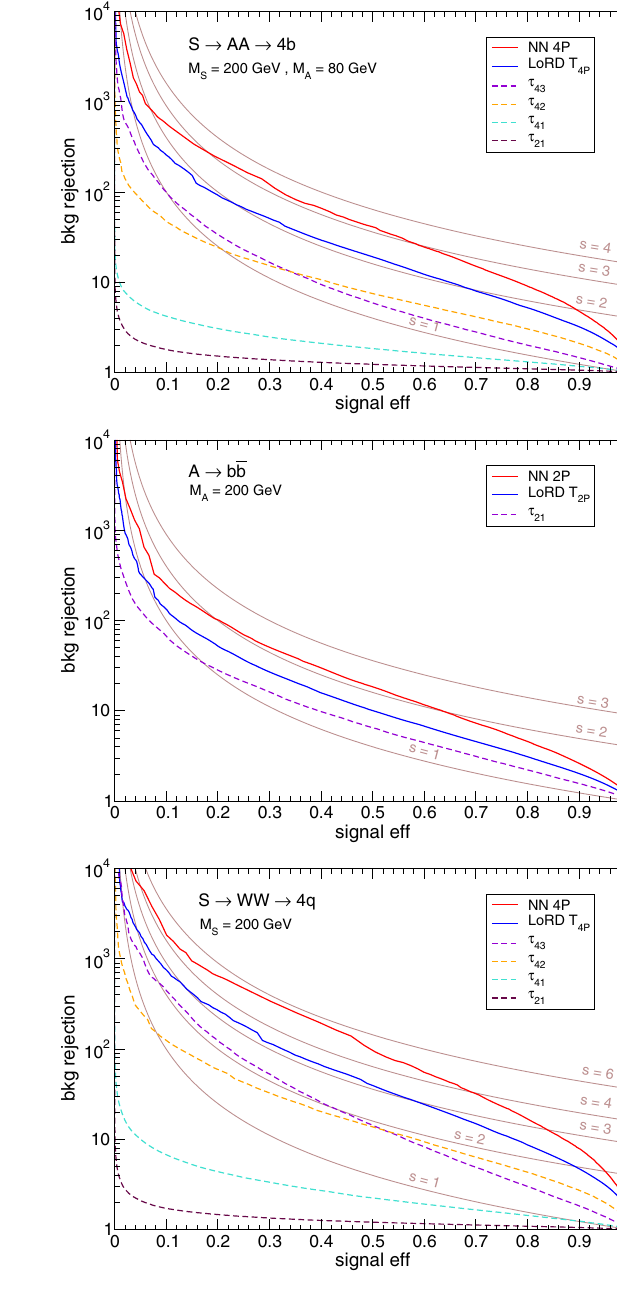
Fig. 3 ROC curves for the hi80 and hi200 taggers applied on selected signals giving multi-pronged jets, compared to τ -ratios and dedicated NNs (see the